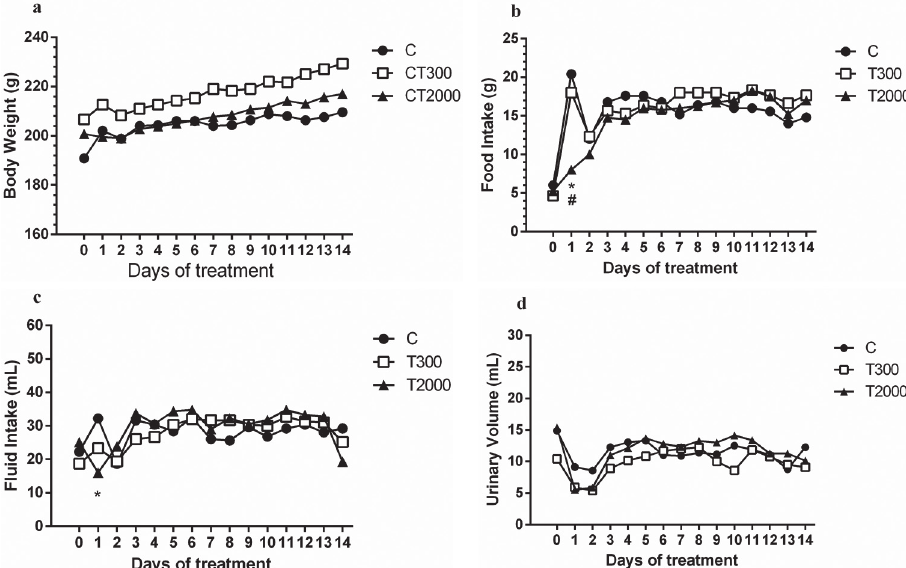
Figure 1 - Effects of acute oral treatment with the EEStb on ( a ) body weight; ( b ) food intake; ( c ) fluid intake and ( d ) urinary volume of control (C), treated with 300 mg/kg (EEStb (EEStb ) groups during 14 2.000